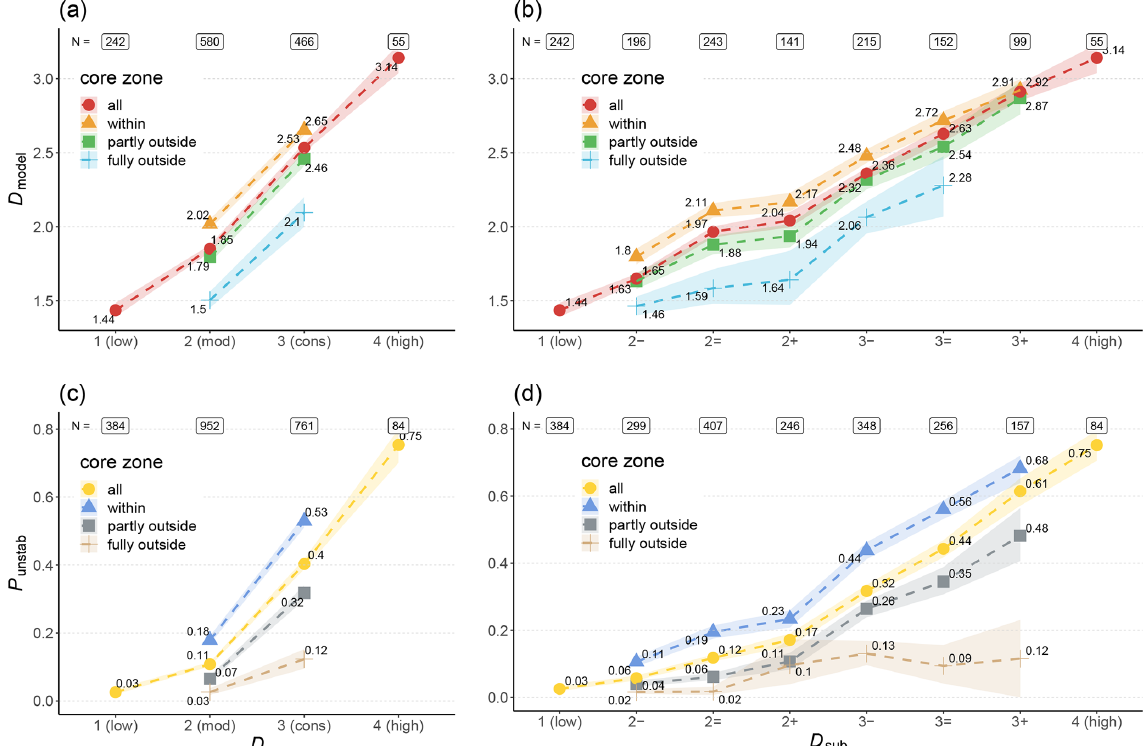
Figure 9. Output from random forest models predicting the danger level (a, b) and instability (c, d) . The mean predicted danger level ( D model ) and the proportion of simulated snow profiles predicted as unstable ( P unstab ) are shown for all cases with the same danger level D (a, c) or sub-level D sub (b, d) . Shown are the median values (points) and the 95% confidence interval (shaded